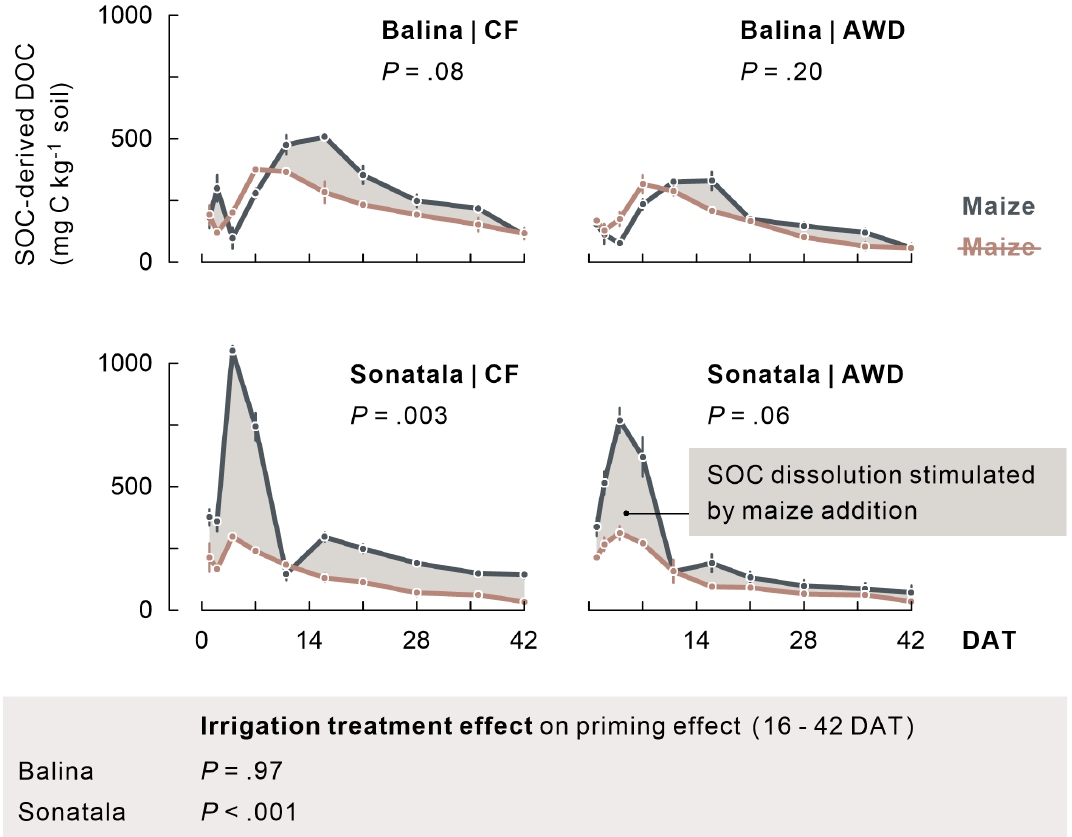
Figure 3. Dissolution of native SOC (average ± standard error of three or two replicates) was stimulated upon addition of maize, as it appears when comparing with DOC in unamended pots (indicated in brown). P -values of the priming effect significance using average values per season (in the figure) and of the irrigation treatment effect on the priming effect time series starting from 16 DAT (below the figure) are